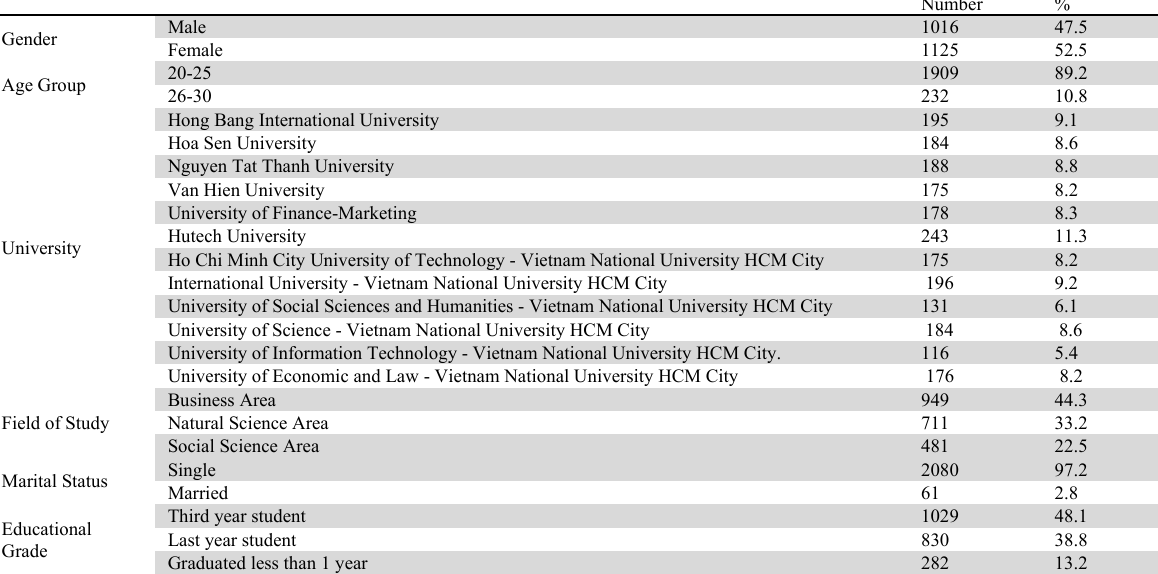
Demographic characteristics of participants (N=